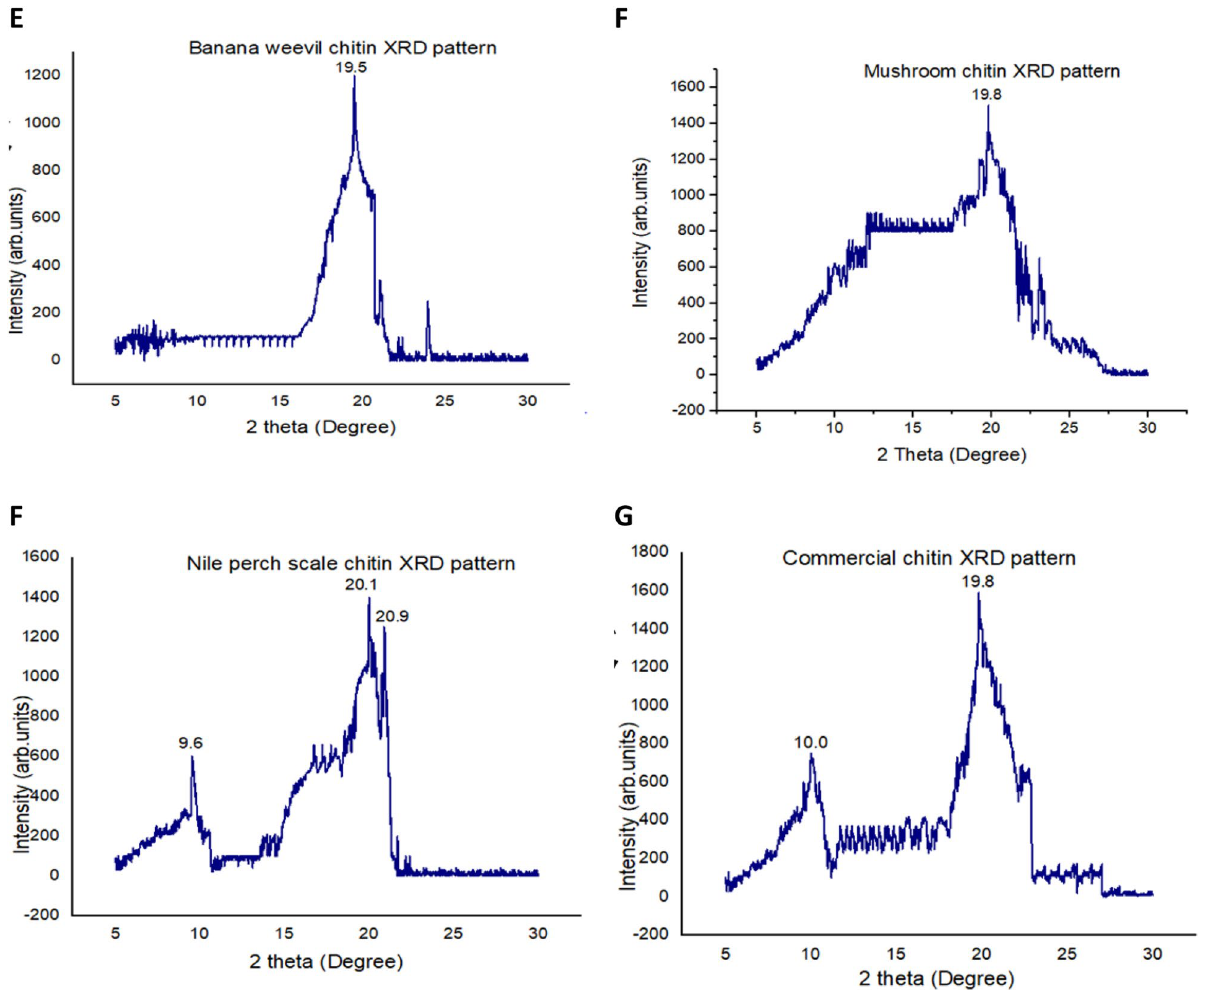
Figure 3. XRD patterns for chitin extracted from locally available material; ( E ) XRD pattern for banana weevil chitin, ( F ) XRD pattern for mushroom chitin, ( G ) XRD pattern for Nile perch scale chitin, and ( H ) XRD pattern for commercial chitin.